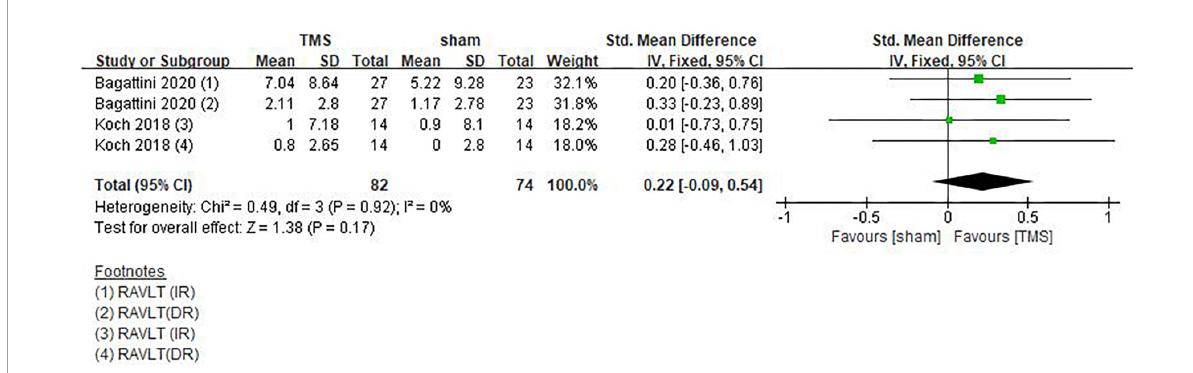
FIGURE10 Forest plot showing the effect of repetitive transcranial magnetic stimulation (rTMS) on RAVLT of AD patients with 95% CI.